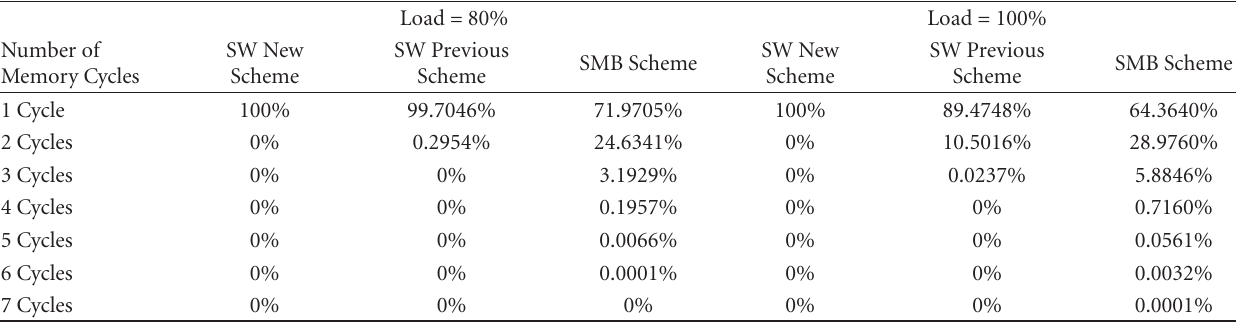
Table 1: Worst-case scenario for number of memory-cycles required per switch cycle for packets’ READ or WRITE memory operations in SMB and SW switches, respectively.